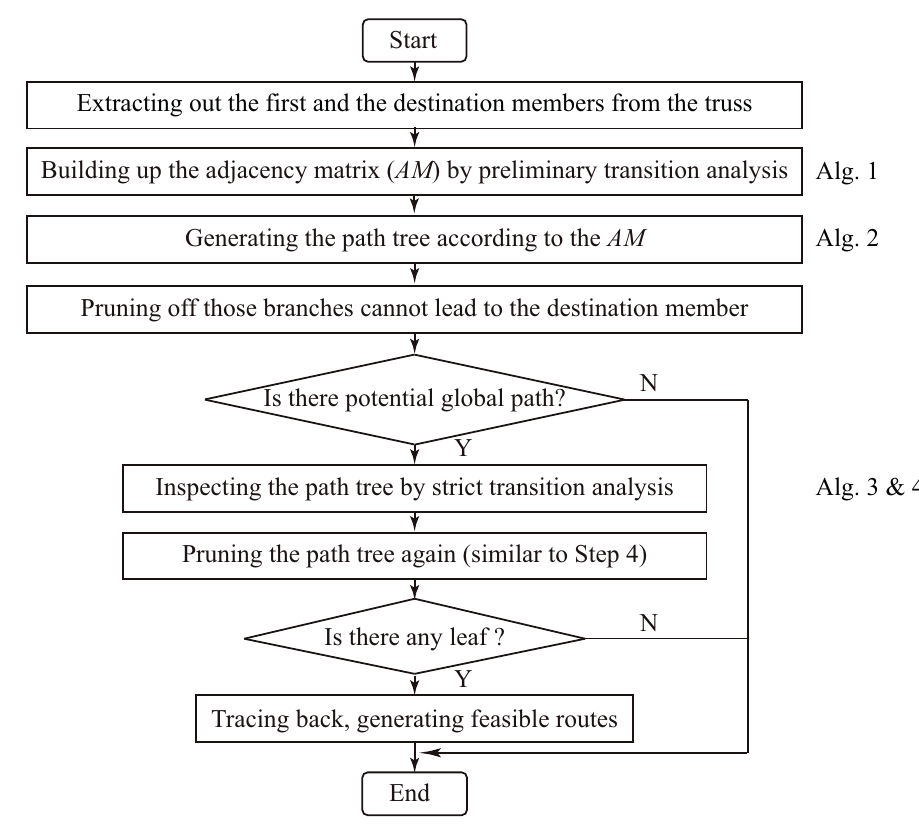
Figure 7. The flowchart of global path